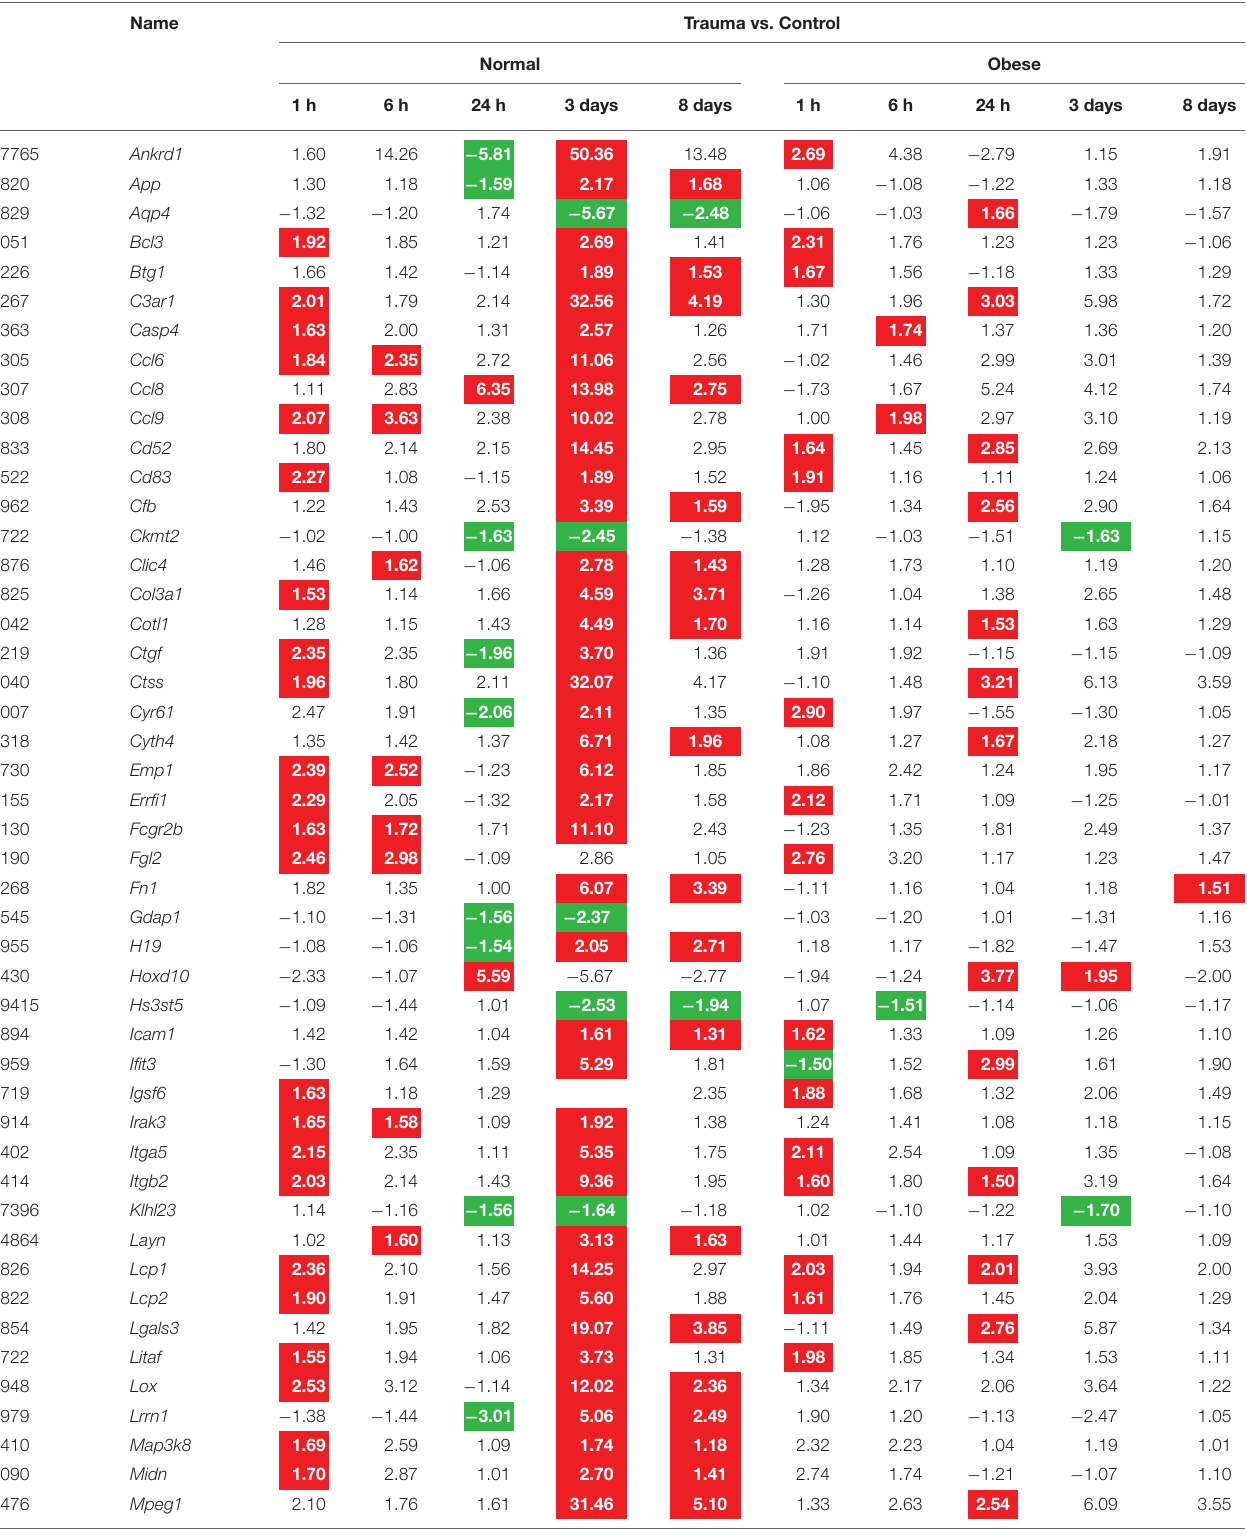
TABLE 3 | Gene expression levels in fold change values determined by microarray analysis with at least three hits and a fold change ≥± 1.5 over all time points independent of